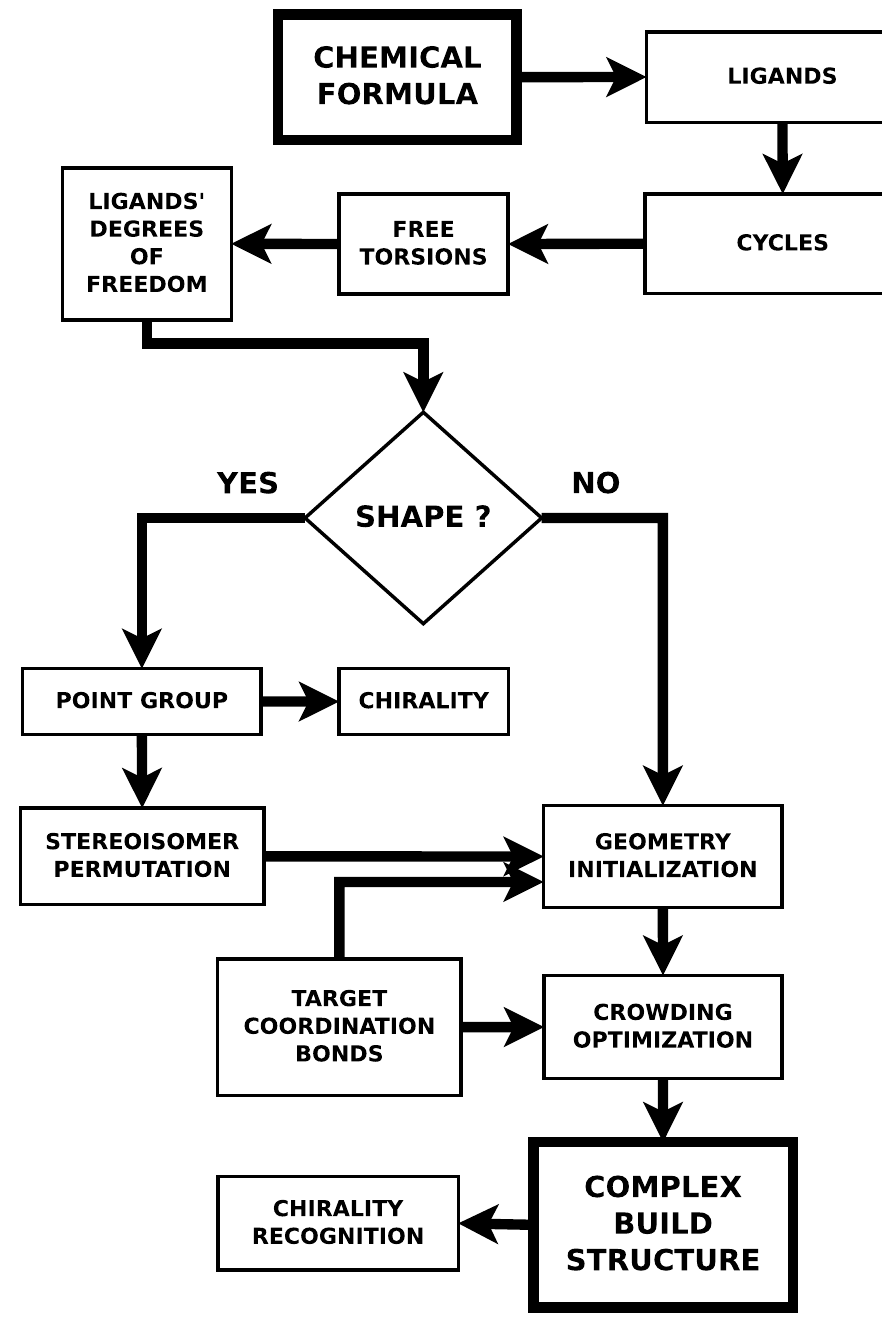
Figure 1. A flowchart describing the hierarchy and links among the various subtasks related to the overall goal of producing, from the chemical formula, 3D structures of a complex that can function as effective starting geometries to be further input into more sophisticated molecular modeling